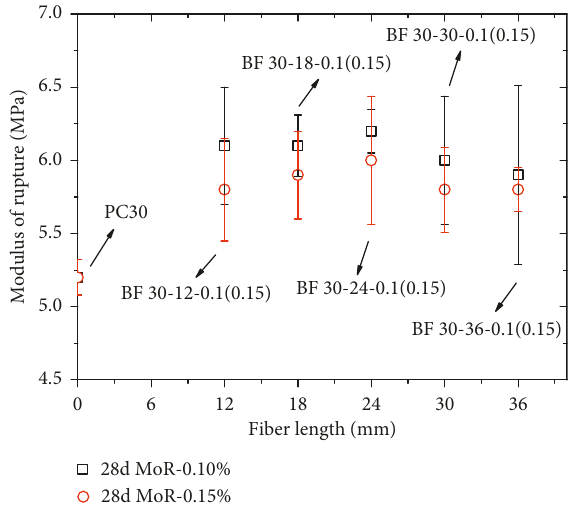
Figure 8: Effect of fiber volume fraction on MoR for specimens PC30 and BF 30-12(24)-(0.075 ∼ 0.3).